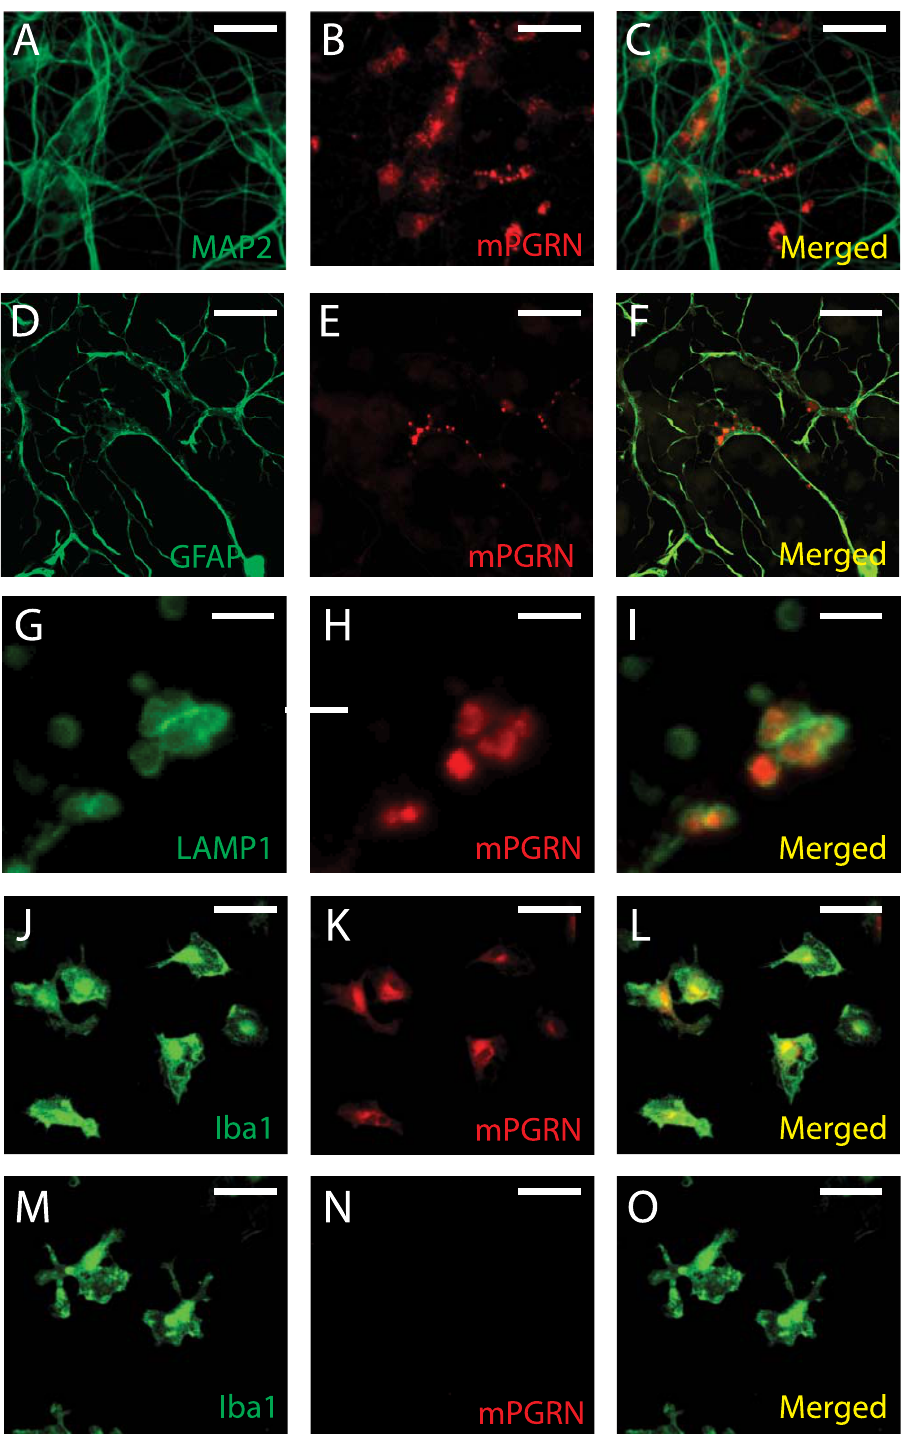
Figure 4. Expression of endogenous PGRN in different brain cell types. ( A–C ) mPGRN is expressed in MAP2-positive cultured mouse cortical neurons. ( D–F ) mPGRN is present in the processes of astrocytes in mixed brain cell cultures. ( G–I ) mPGRN seems to be localized in LAMP1-positive vesicles. ( J–L )mPGRNishighlyexpressedinIba1-positiveculturedmousemicroglia.( M–O )Anti-mPGRNspecificallyrecognizestheendogenous mPGRNproteinsince the immunostaining signal is absence in Iba1-positive microglia (M) isolated from GRN knockout mice (N). Scale bar: 20 m m for all panels except G–I (3 m